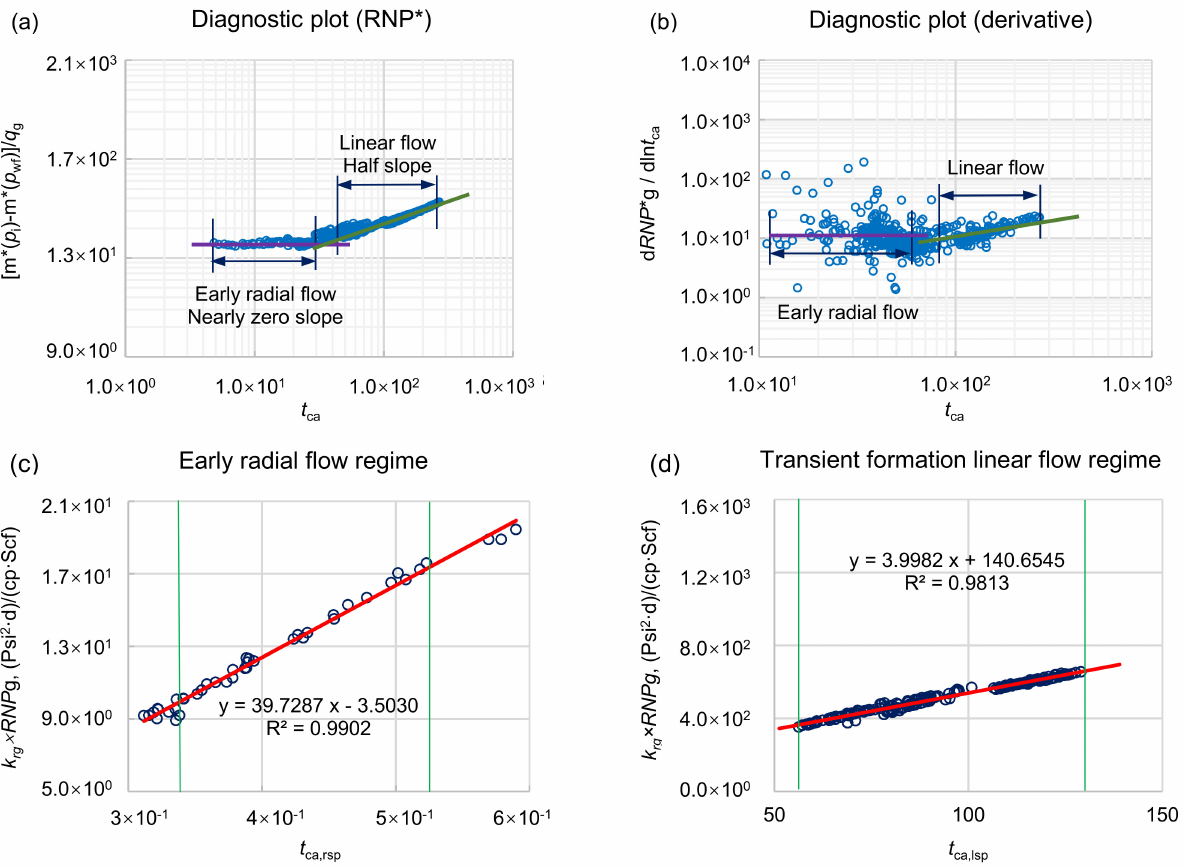
Figure 10. The use of two phase RTA techniques for analyzing flow regimes associated with a horizontal well in the field example: ( a ) diagnostic curve (RNP*), ( b ) diagnostic curve (derivative), ( c ) early radial flow of gas phase, and ( d ) formation linear